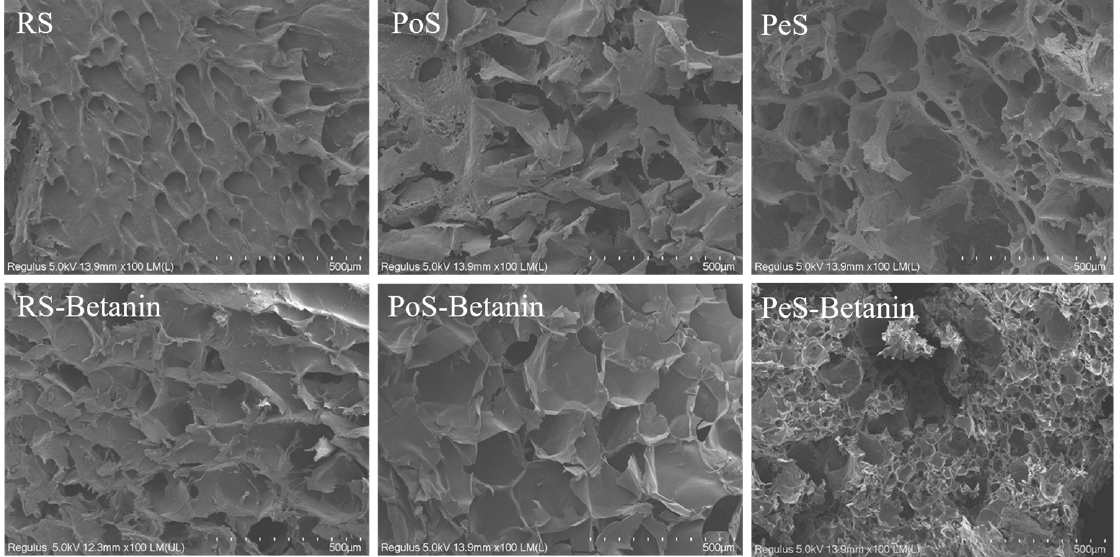
Figure 6. SEM photographs of starches and starch–betanin samples after retrogradation for 7 days.